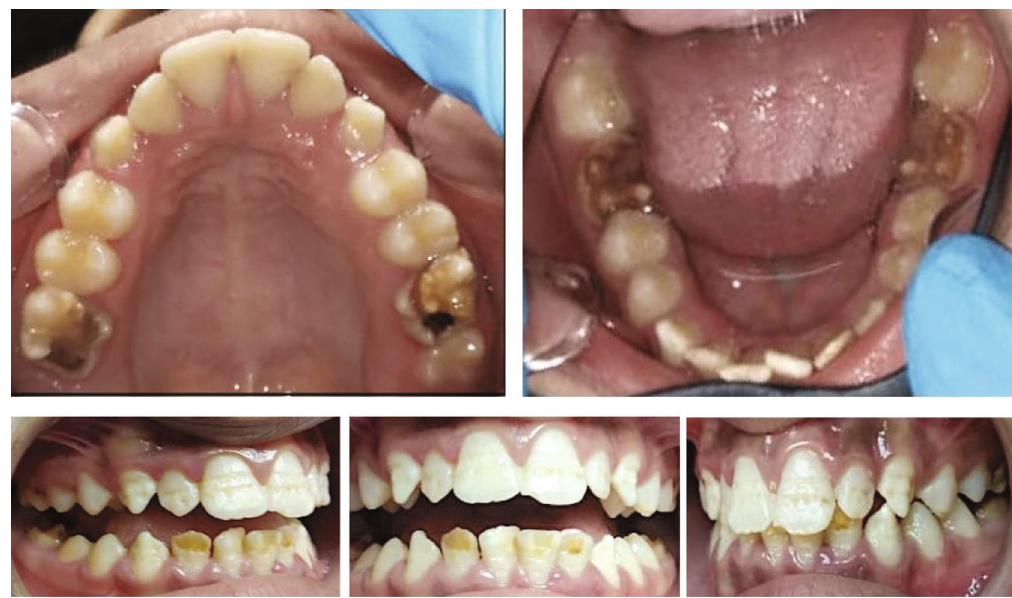
Figure 1: Preoperative intraoral